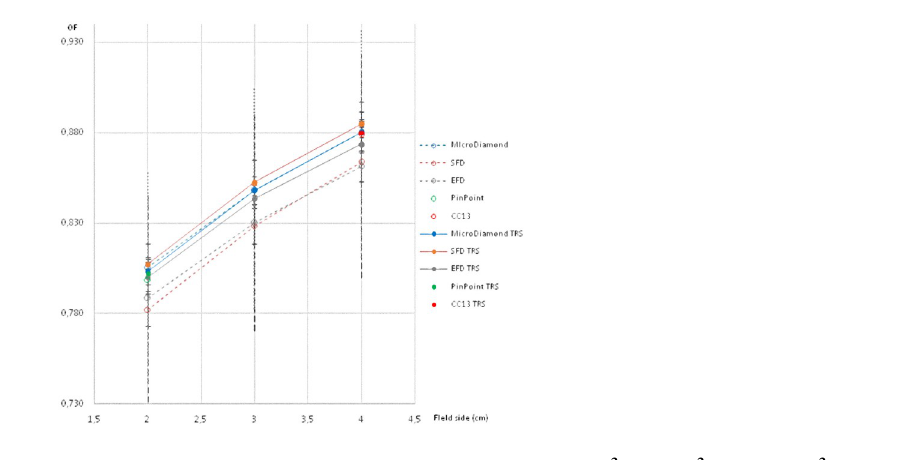
Fig 1. Ratio of detector readings and output factors for the 2 × 2 cm 2 , 3 × 3 cm 2 , and 4 × 4 cm 2 fields for the 6 MV beams.